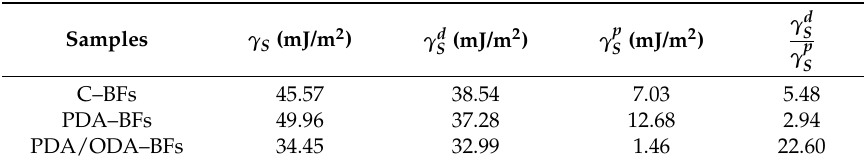
Table 4. Surface energy calculated by OWRK